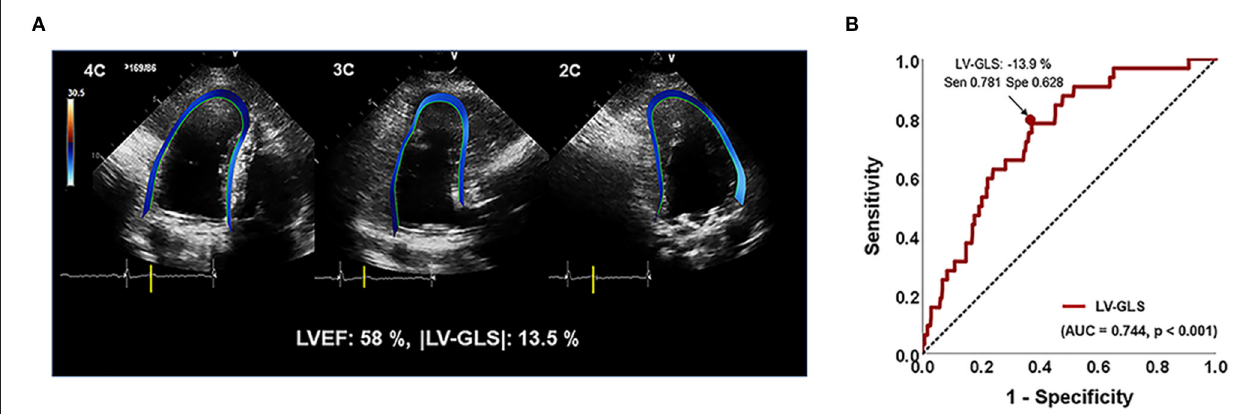
FIGURE 1 | (A) Representative images for assessing LV-GLS. (B) Area under the receiver-operating characteristics curve (area under the curve) of |LV-GLS|. |LV-GLS|, the absolute value of left ventricular longitudinal strain. The Arrow indicated that the position of the value of sensitivity and specificity of 78% and 63% when |LV-GLS| has largest AUC.